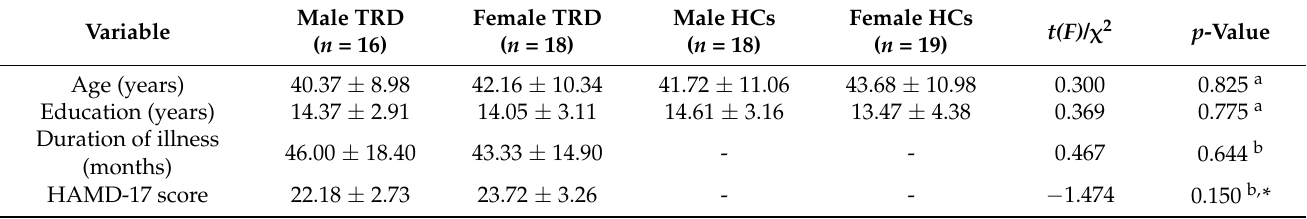
Table 1. Demographic and clinical characteristics of all of the participants.